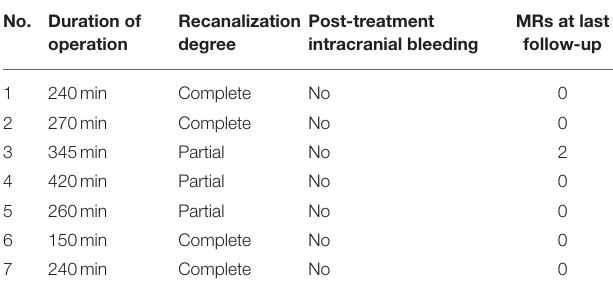
TABLE 3 | Treatment and follow up information of the seven